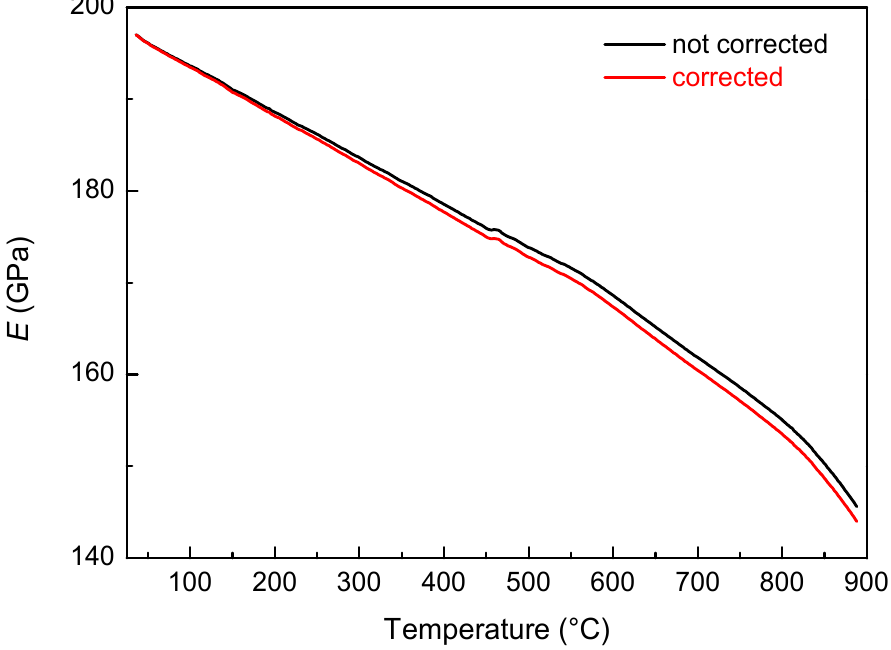
Figure 5. Comparison between dynamic modulus vs. temperature with (red line) and without (black line) thermal expansion correction.